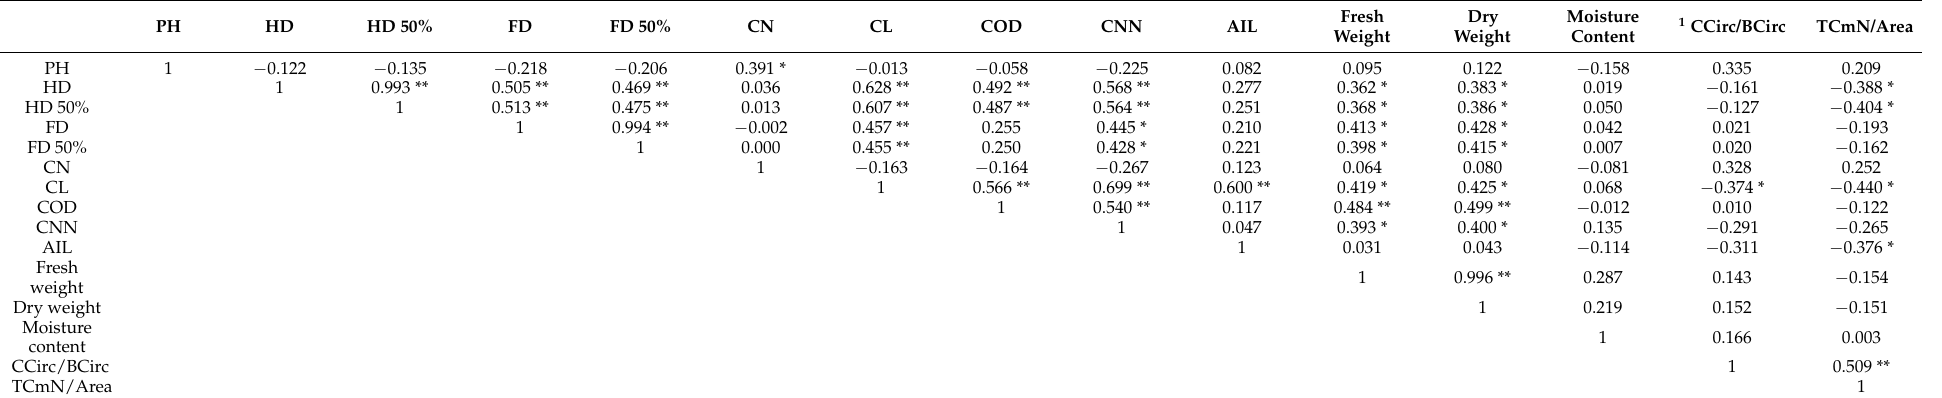
Table 4. Pearson’s correlation coefficients between the main morphological characteristics in M. sacchariflorus